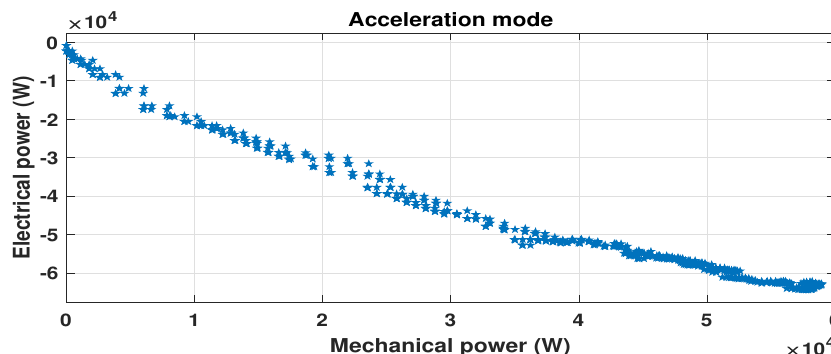
Figure 8. Efficiency of electric vehicle in acceleration mode.